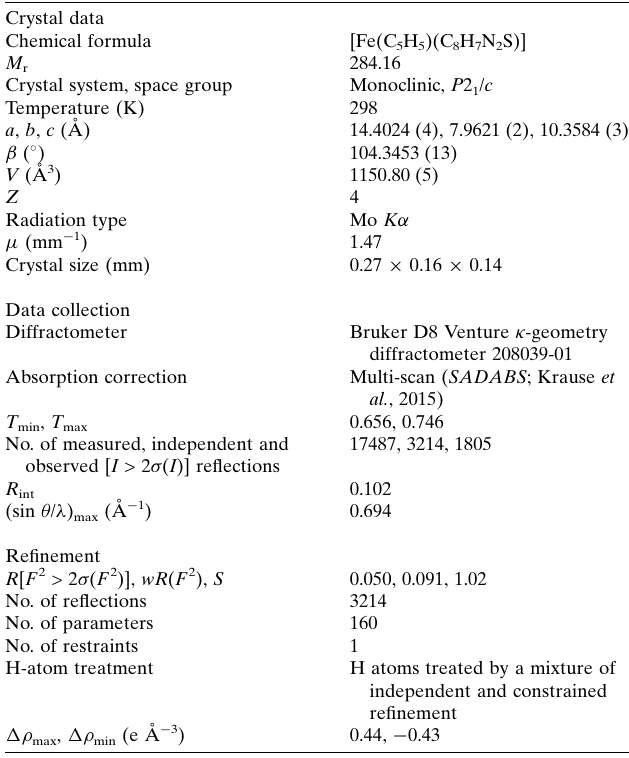
Table 1 Hydrogen-bond geometry (A˚ , (cid:2) ). Cg 1 is the centroid of the C1–C5 Cp ring.